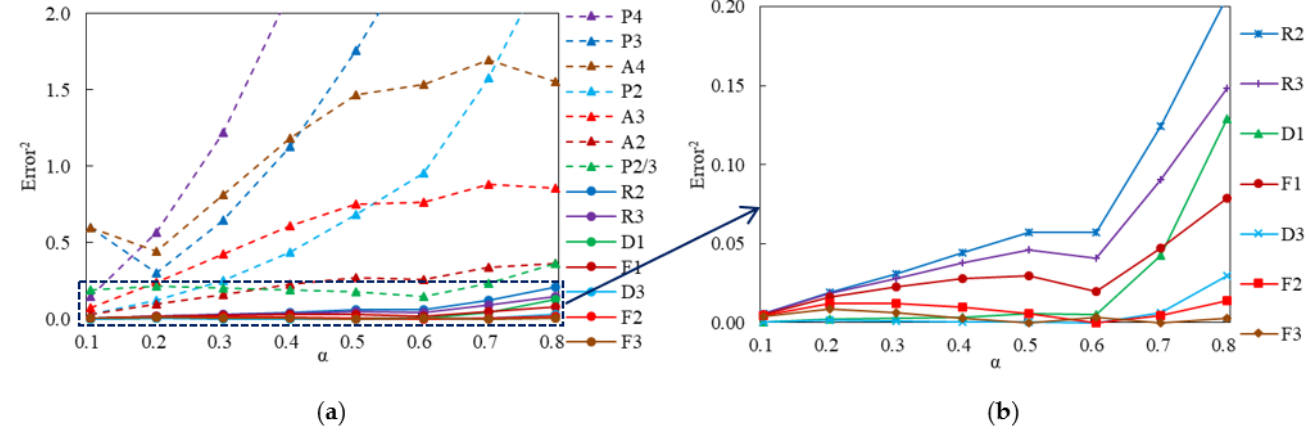
Figure 2. Difference in the d α / d θ between the calculation of different potential reaction models (cf. Table 1 in [19] for details) and the experimental results, as calculated by Equation (11): ( a ) the plots for all the common reaction models ( b ) the zoom-in of the seven plots at the bottom.